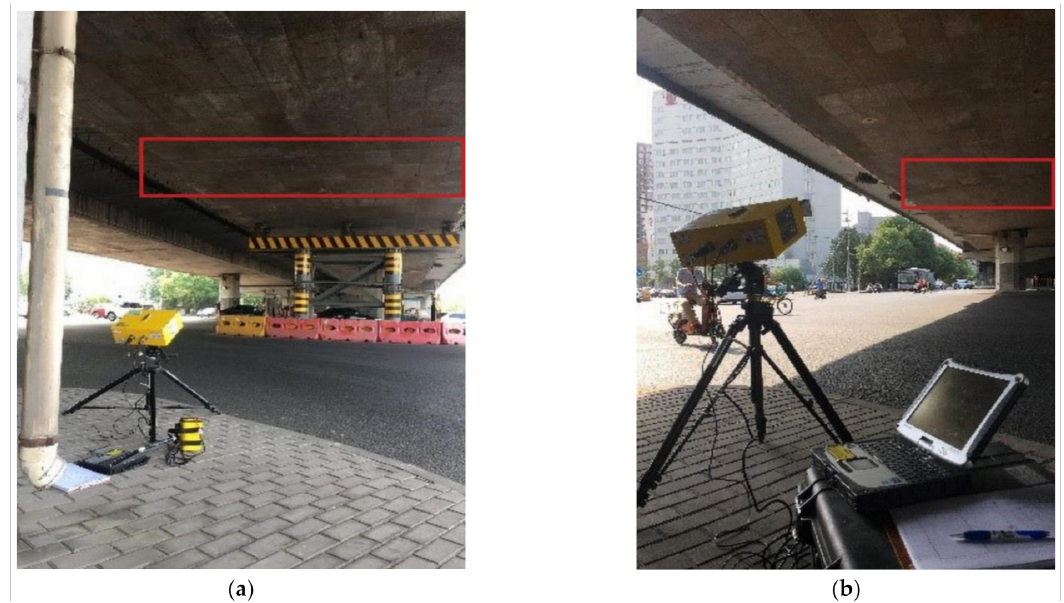
Figure 4. Layout of IBIS-S to obtain dynamic deflection. ( a ) Layout of IBIS-S of RSB and ( b ) layout of IBIS-S of